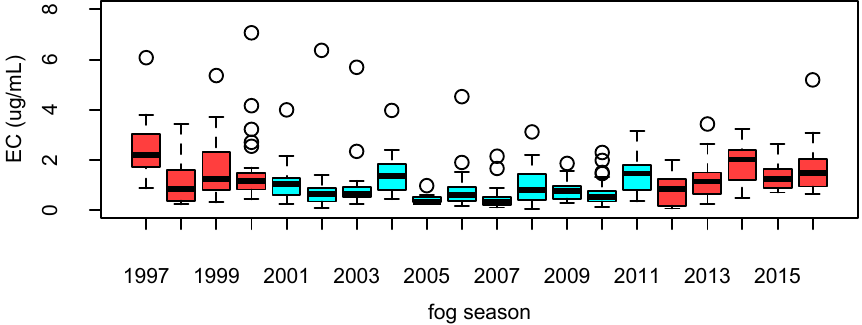
Figure 4. Box and whisker plots of EC concentration in fog water during the different fog seasons; measured concentrations are in red, and estimated concentration in cyan.